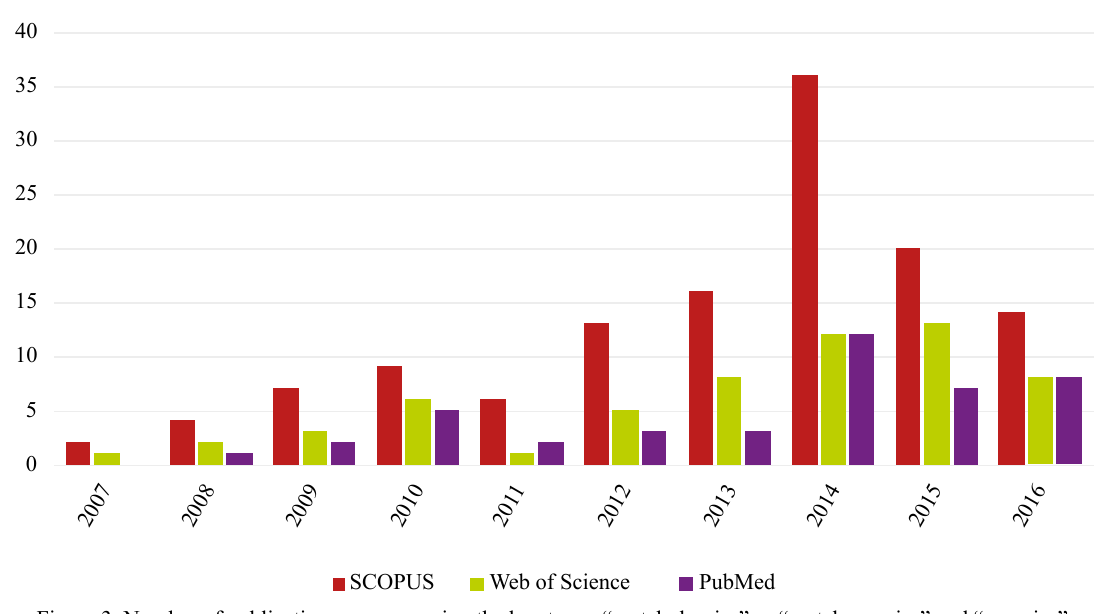
Figure 3. Number of publications per year using the key terms “metabolomics” or “metabonomics” and “exercise”.